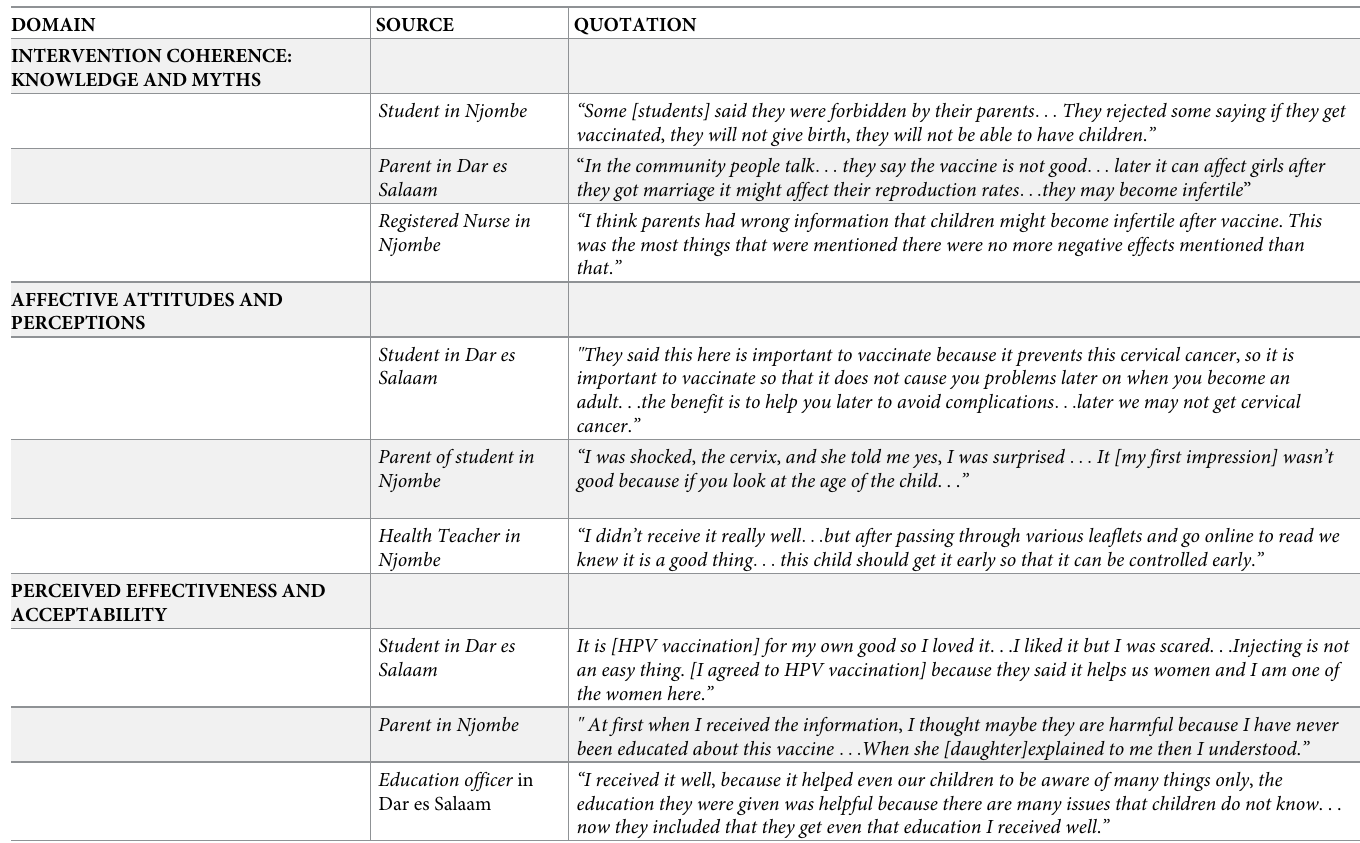
Table 2. Additional stakeholder